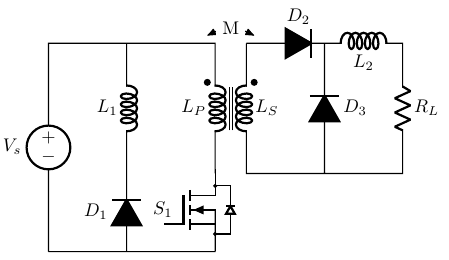
Figure 16. General Setup of the Transformer-Based